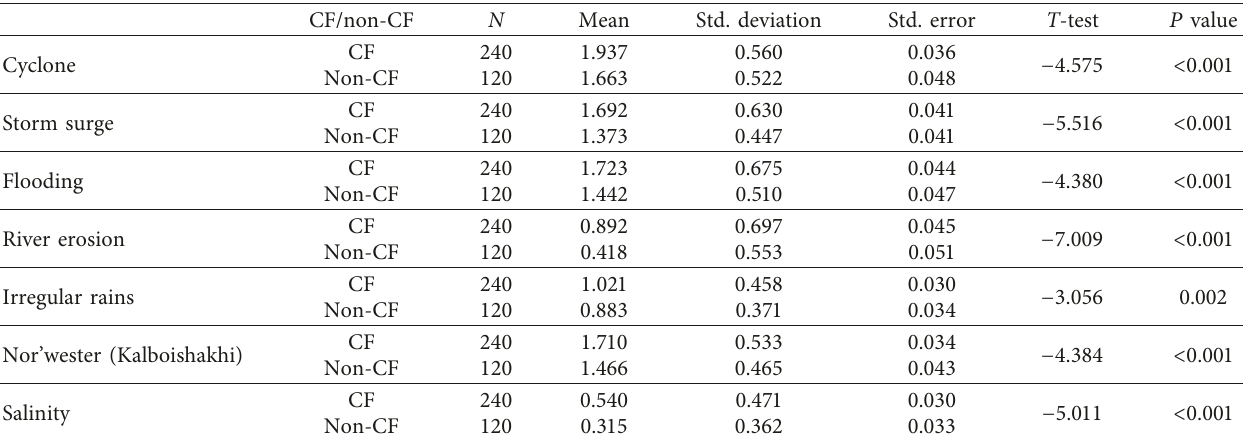
Table 6: Mean, standard deviation, and standard error of the perceived severity, i.e., the effect of climatic events on different dimensions of the households. CF/non-CF N Mean Std. deviation Std. error